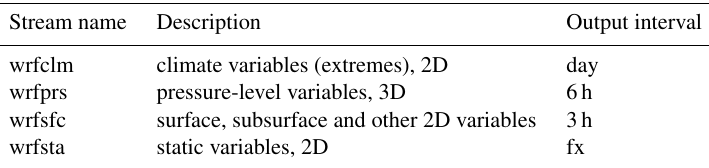
Table A2. Description of streams into which the WASCAL WRF output variables are classified.